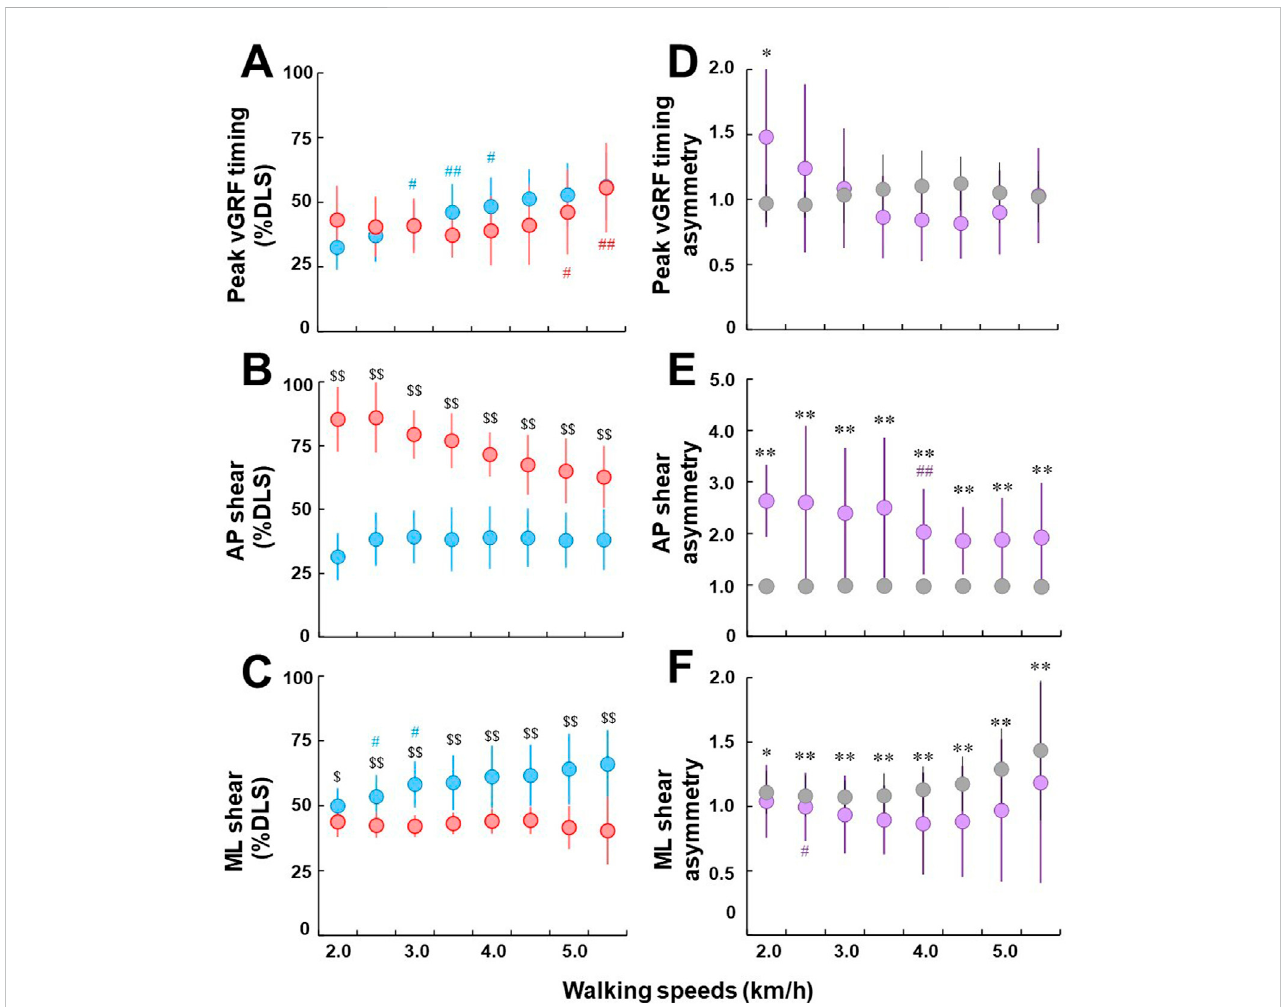
FIGURE 5 (A – C) : Comparisons of peak vGRF timing (A) , AP shear (B) , and ML shear (C) between initial (blue) and terminal double limb stance (red), respectively. Circles and error bars indicate the mean value and the standard deviation in each DLS, respectively. # and ## represent signi fi cant differences between the currentandpreviousspeedsat p < .05and p < .01,respectively.$and$$representsigni fi cantdifferencesbetweeninitialandterminaldoublelimbstanceat p < .05and p < .01,respectively. (D – F) :comparisons ofpeakvGRFtimingasymmetry (D) ,APshearasymmetry (E) ,andML GRFshearasymmetry (F) between individuals with uTFA (purple) and the control group (gray). Circles and error bars indicate the mean value and the standard deviation in each group, respectively.*and**representsigni fi cantdifferencesinasymmetryratiobetweentheindividualswithUTFAandcontrolgroupsat p <